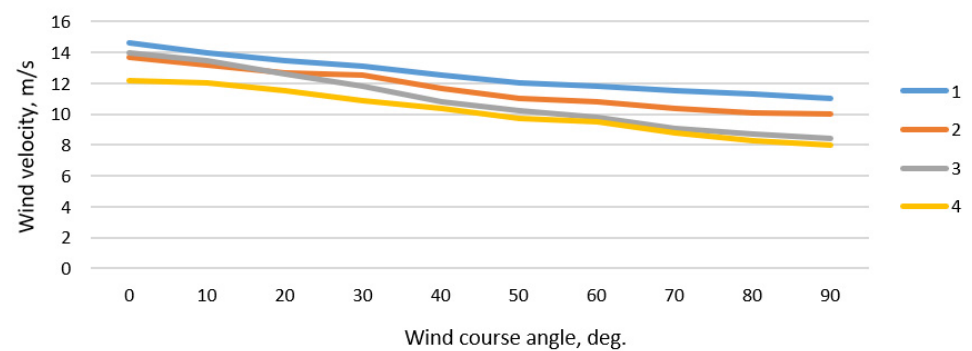
Figure 15. Limitations of wind velocity depending on wind course angle during ships departure from Klaipeda port, where: 1—LNG standard tanker; 2—SUEZMAX loaded tanker; 3—G class container vessel; 4—SUEZMAX tanker in ballast.